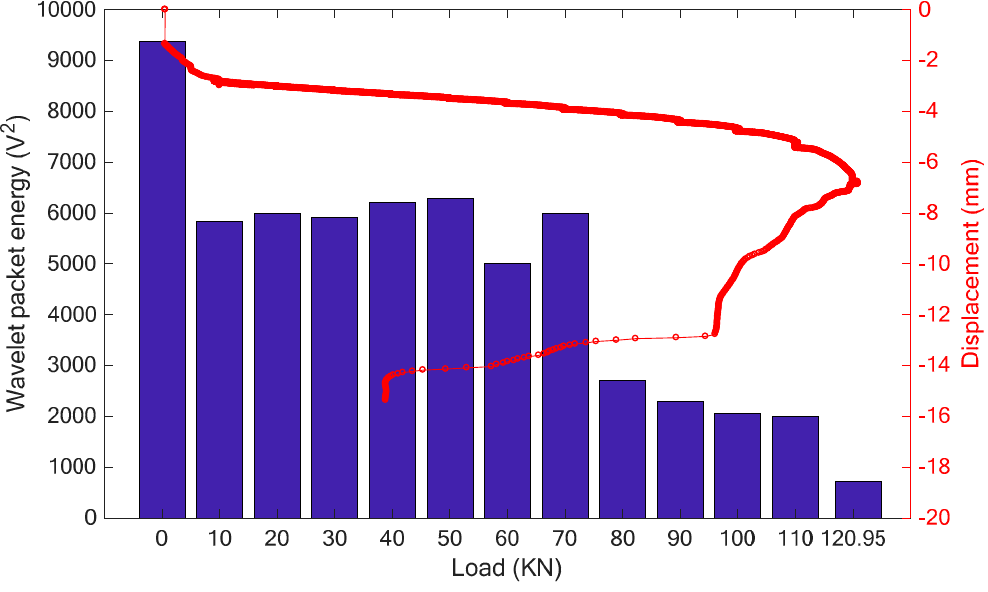
Figure 17. The result of wavelet packet energy.